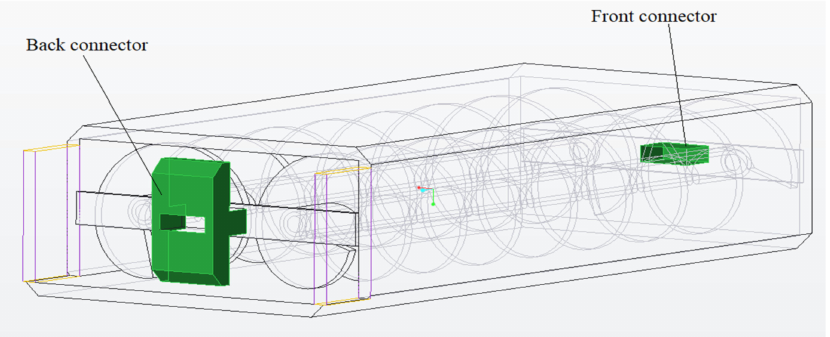
Figure 4. Addcar (performed by the authors).